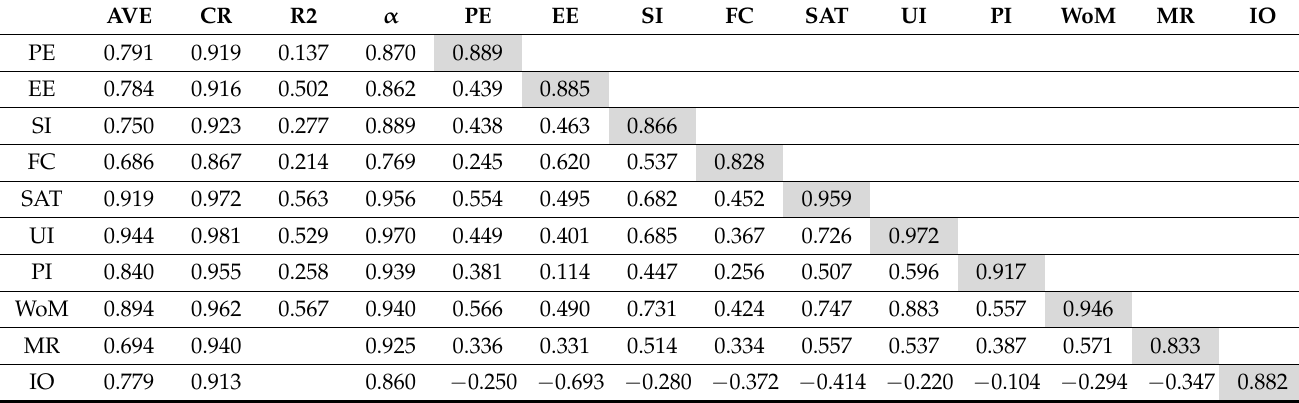
Table 4. Latent variables correlations.